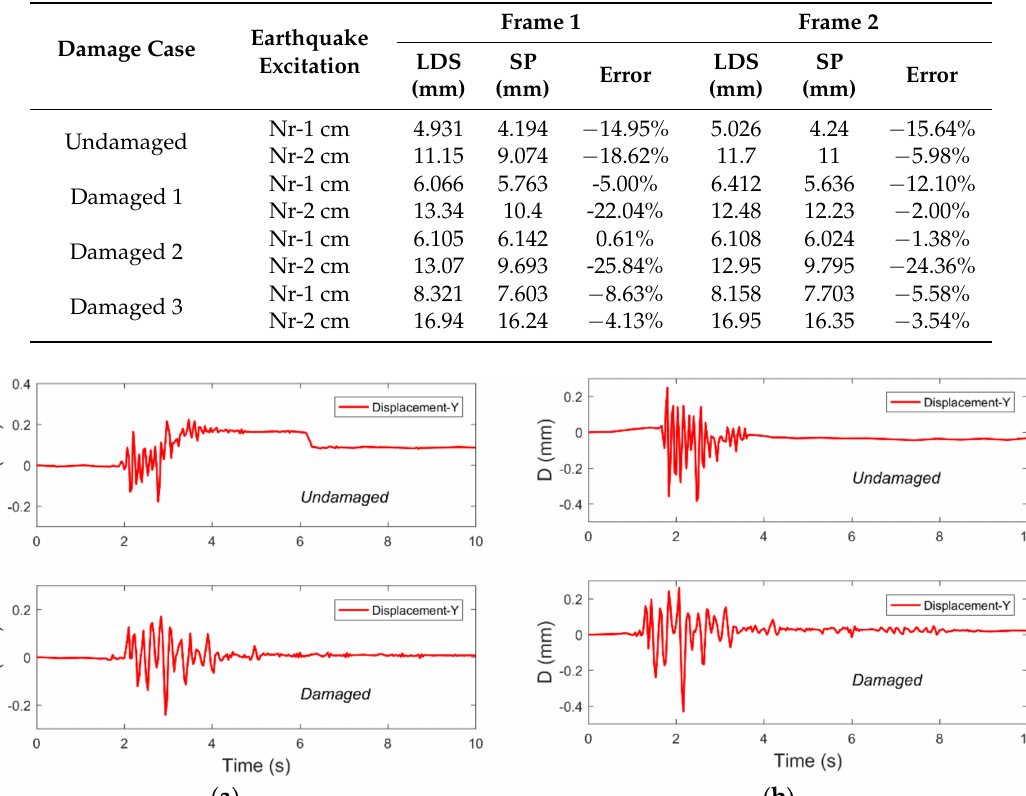
Table 5. Peak values of displacement under different excitations by two kinds of sensors.